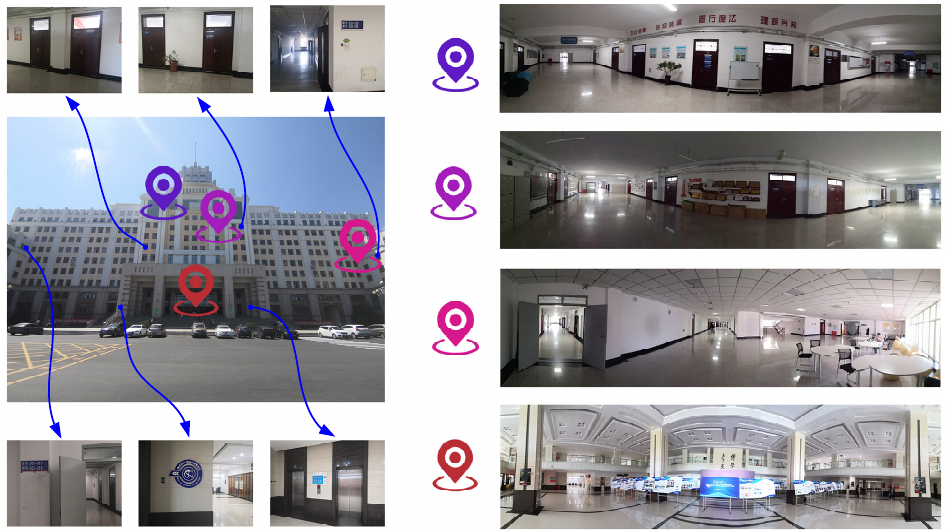
Figure 15. The actual scene and appearance of the Huiwen Building. The blue points represent the positions of some experimental images on the exterior of the building. Some areas of the teaching building are displayed in four panoramic pictures on the right according to the corresponding colours.